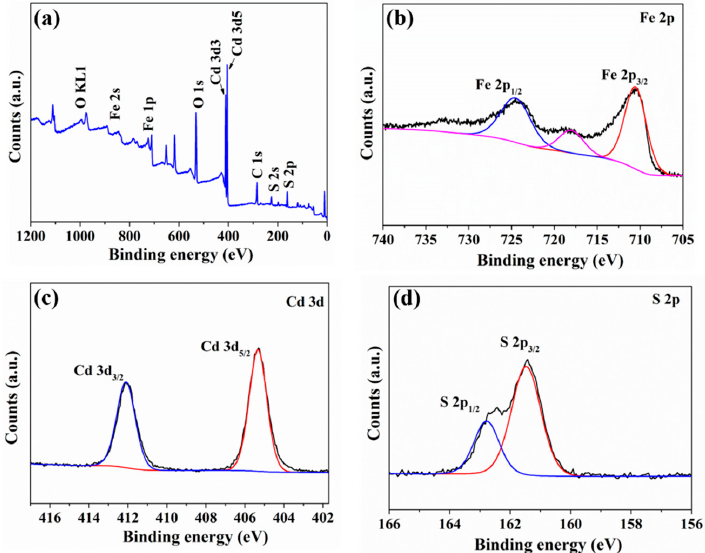
Figure 4. XPS spectra of the 5-CdS/F450. ( a ) Survey; ( b ) Fe 2p; ( c ) Cd 3d; ( d ) S 2p.